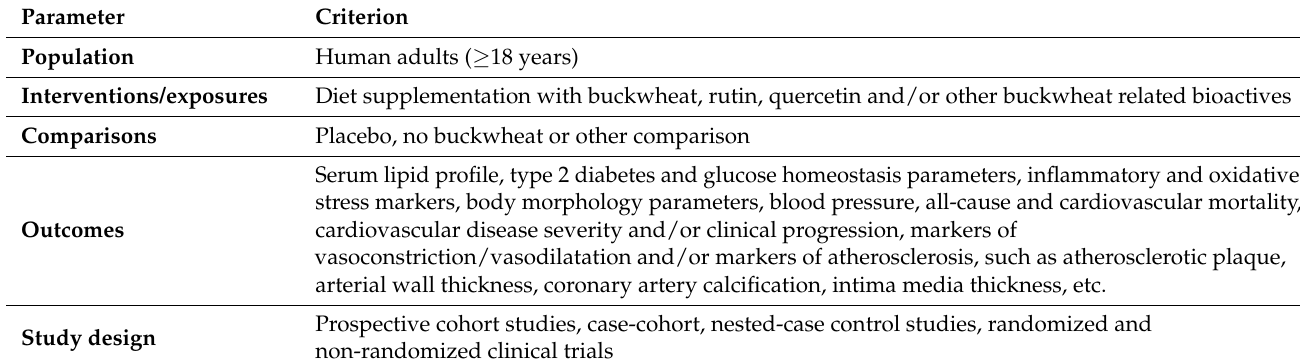
Table 1. PICOS criteria for inclusion of